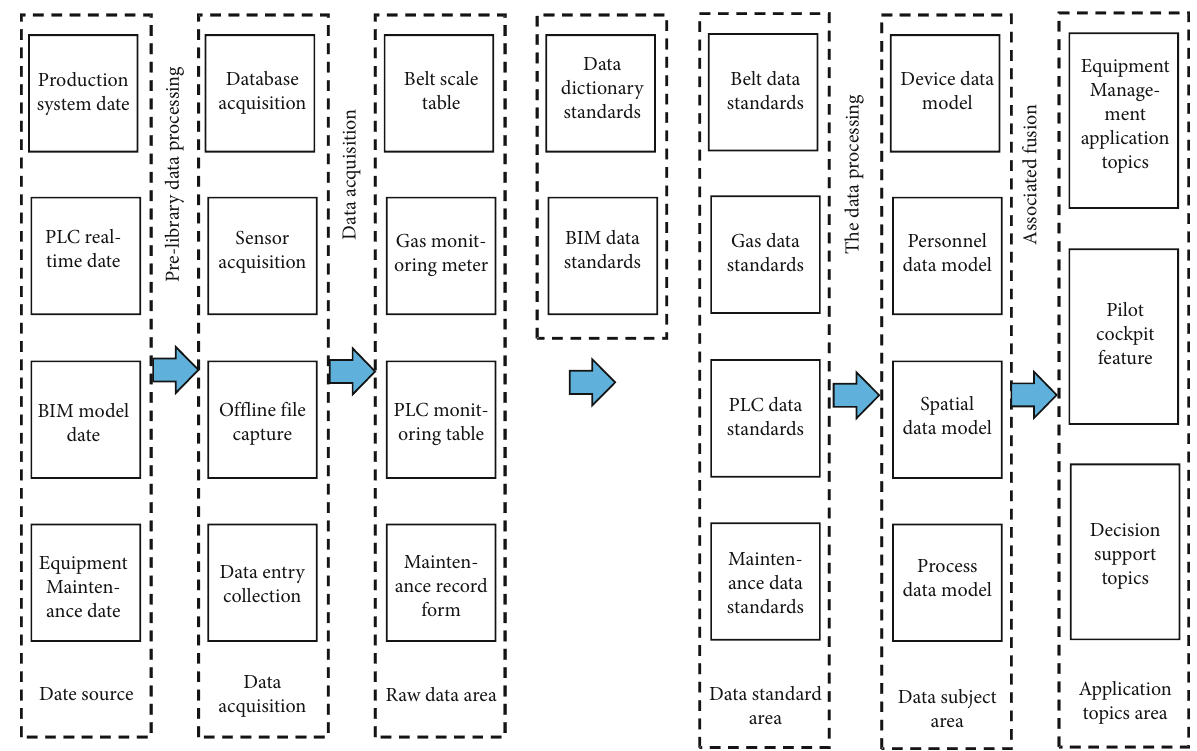
Figure 4: Data architecture